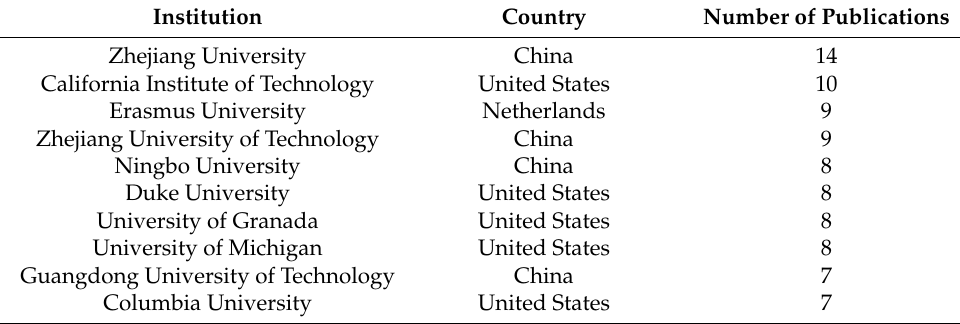
Table 1. Institutions with the largest number of